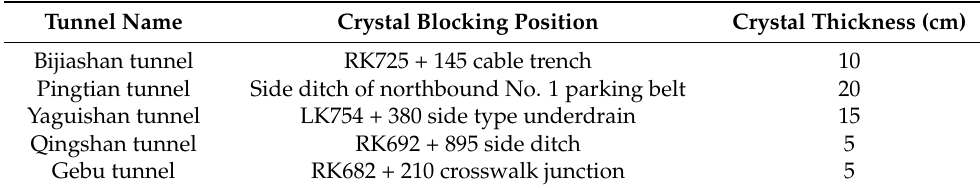
Figure 3. Disease distribution of drainage system of the highway tunnel. Table 2. Tunnel crystallization blocking